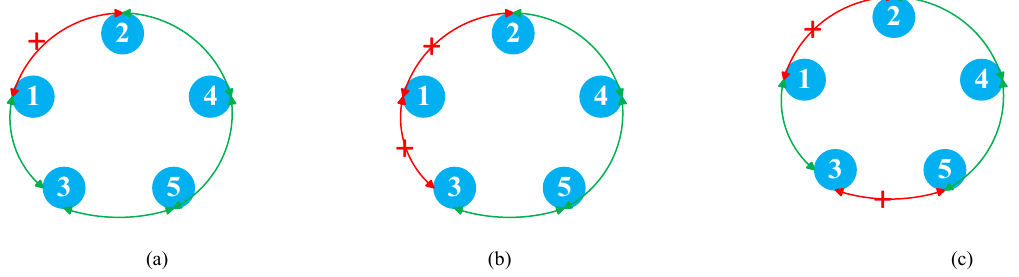
Figure 20. Communication networks and three types of failures of five DGs in the experiment